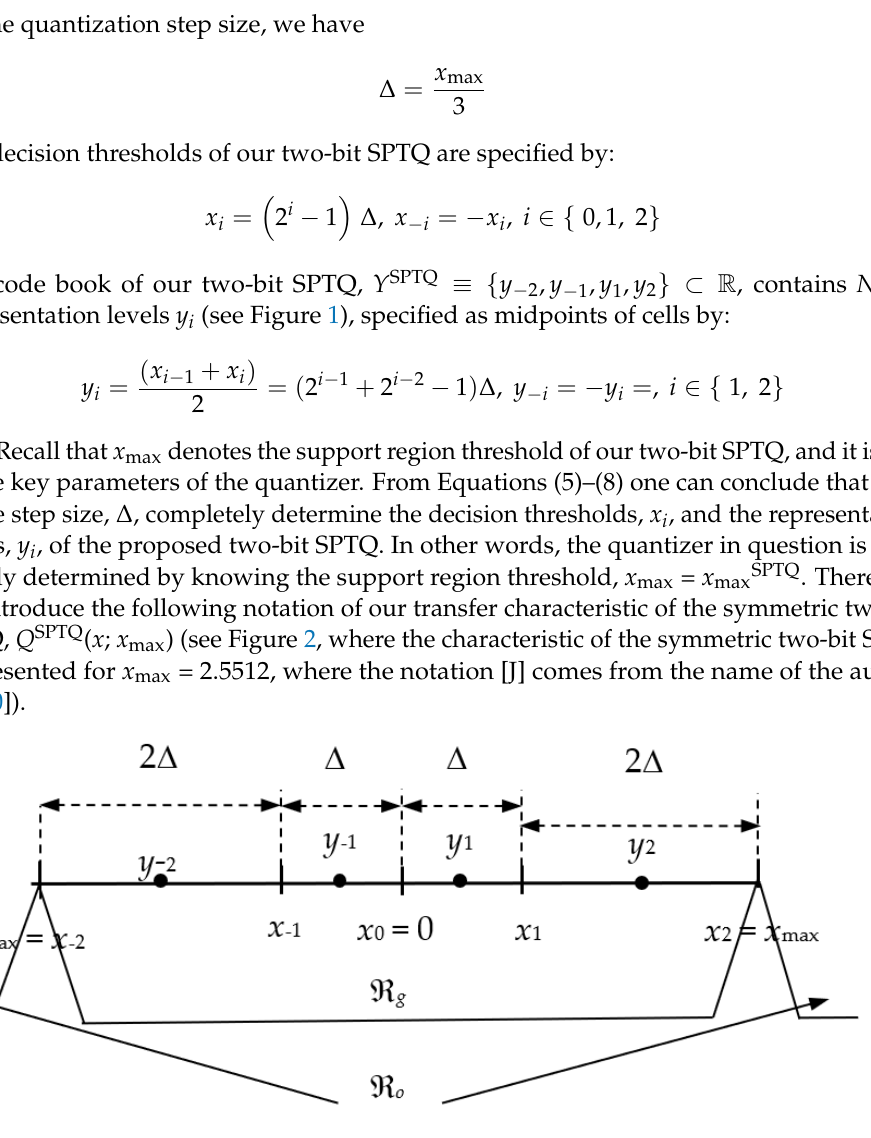
Figure 1. Granular region, ℜ g , and overload region, ℜ o , of the symmetric two-bit SPTQ.